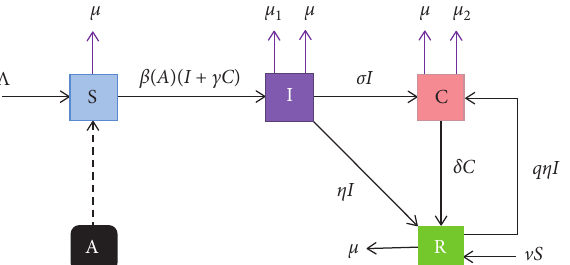
Figure 1: Transfer diagram of liver cirrhosis. Hence, combining equations (1)–(5) above together with the assumptions (i)–(v), finally, we obtain the following system of differential equations for the progression dynamics of liver